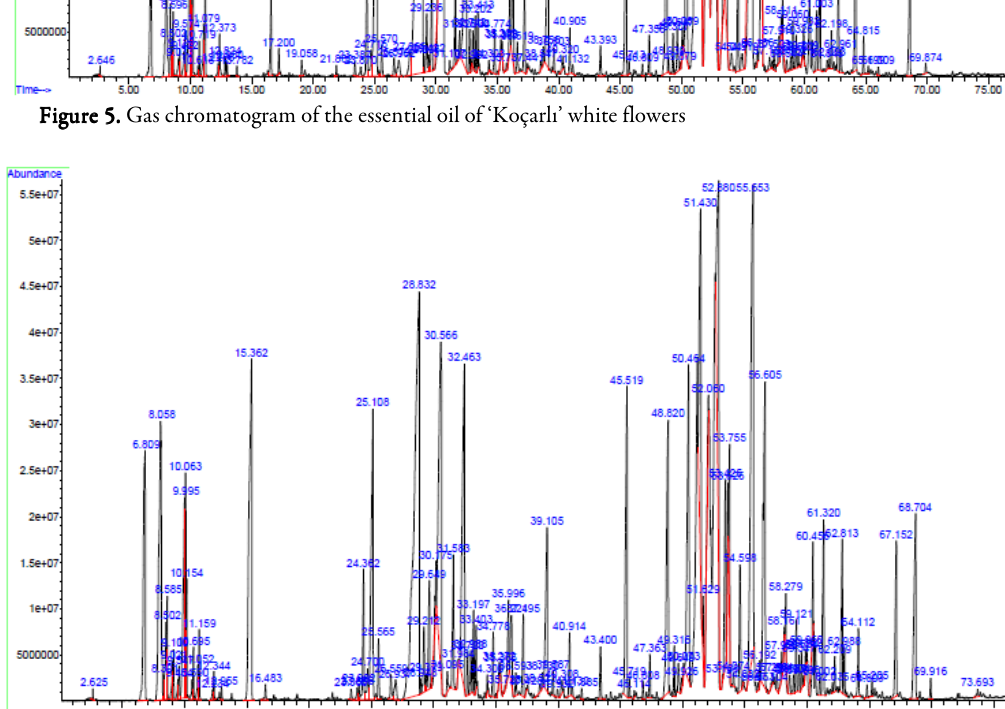
Figure 6. Gas chromatogram of the essential oil of ‘Koçarlı’ pink flowers The biplot diagram for the first and second components shows the correlation of the studied flowers based on the volatile compounds detected. According to the data obtained, the first and second components (PC1 and PC2) explained 59.7% of the total variance. Except for ‘Çakmar’ purple flower, ‘Çakmar’ and ‘Koçarlı’ flower populations were collected in two different groups according to PC1 (Figure